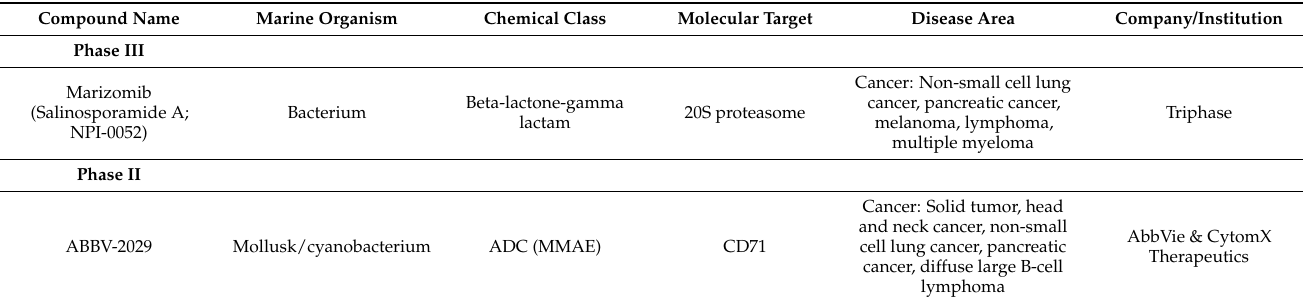
Table 2. Compounds derived from marine organisms and currently in clinical trials for the treatment of hematological tumors. ADC, antibody–drug conjugate; MMAE, microtubule inhibitor monomethyl auristatin